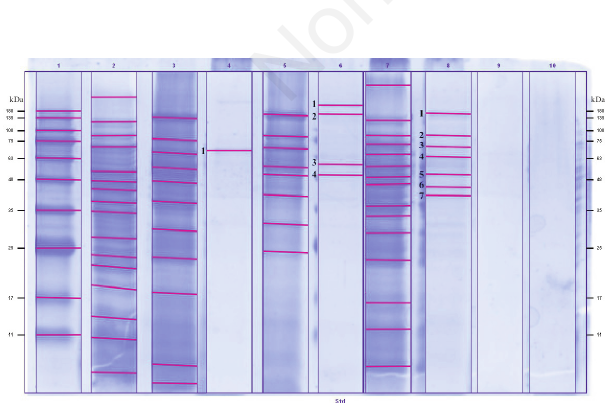
Figure 1. Results of electrophoresis. KDa = weight of molecules in kilo dalton, lane 1 = marker, lane 2 = standard (planktonic), lane 3 = glucose-induced pellet, lane 4 = glucose-induced biofilm, lane 5 = lactose-induced pellet, lane 6 = lactose-induced biofilm, lane 7 = soy protein-induced pellets, lane 8 = soy protein-induced biofilms, lane 9 = substance-induced pellets, lane 10 = iron- induced biofilms.